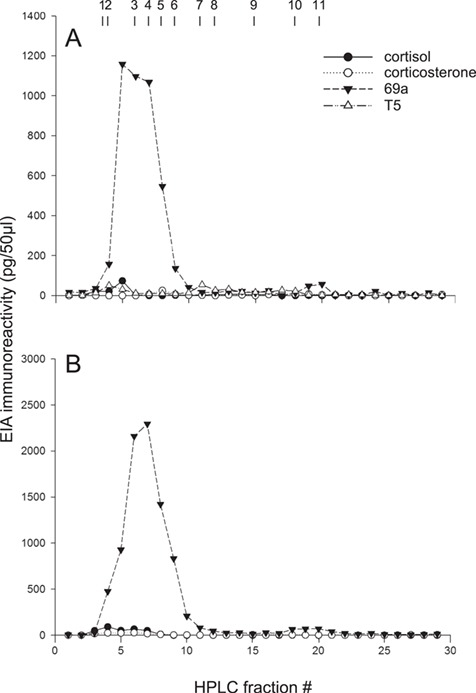
EIA immunoreactivity of fractions separated by HPLC for cortisol (filled circles), corticosterone (open circles), 69a (filled triangles) and T5 (open triangles) in faecal extracts from male (Panel A) and female (Panel B) zoo-managed mandrills. Numbered arrows indicate HPLC elution times for steroid standards: aldosterone (1), cortisol/cortisone (2), corticosterone (3), 69a (4), 72t/5α-androstane-3,11,17-trione (5), 5β-androstan-3, 11, 17-trione (6), T5 (7), androstenedione/dehydroepiandrosterone (8), epiandrosterone/5ß-androstane-3ß-ol-17-one/5ß-dihydrotestosterone (9), etiocholanolone (10) and androstanedione/androsterone (11).